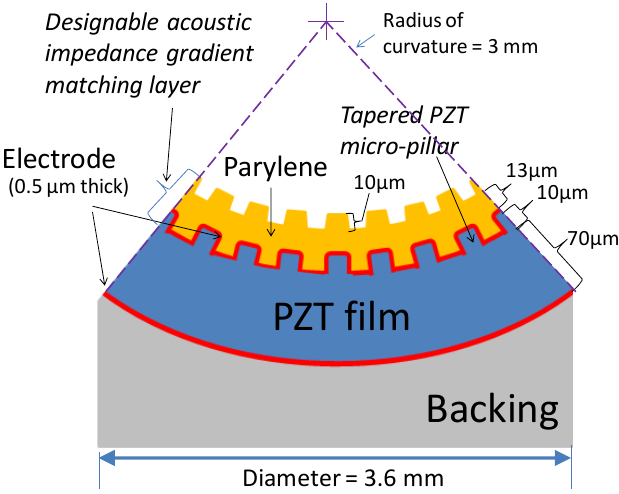
Figure 1. Illustration of the configuration of the cross-sectional view of proposed spherically-shaped ultrasonic transducer with an acoustic impedance gradient matching